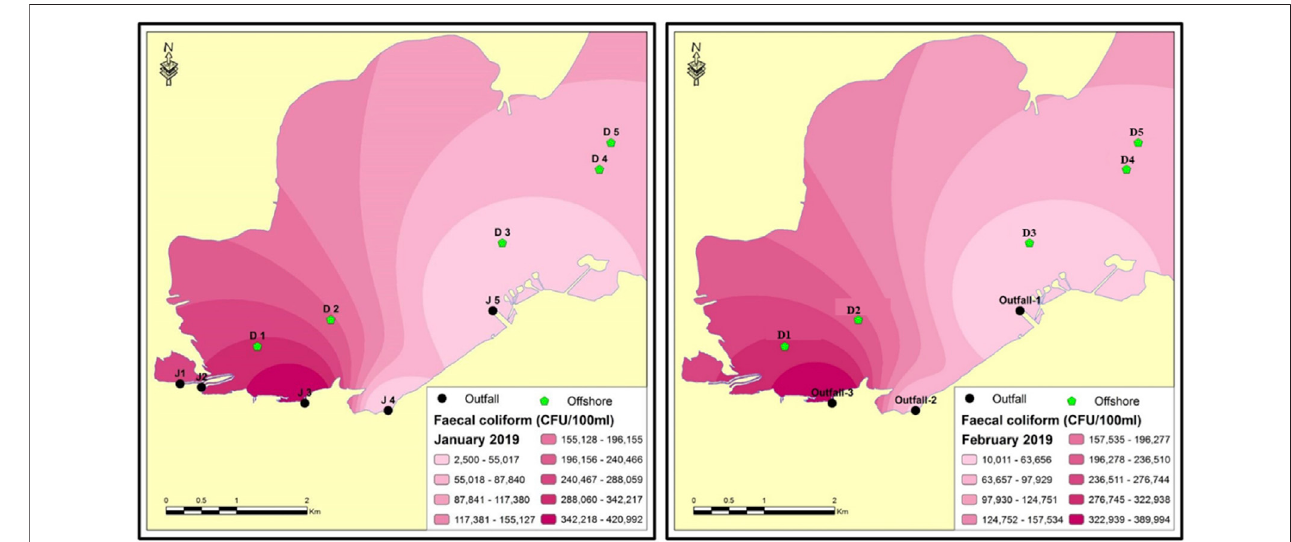
FIGURE 6 | Distribution of fecal coliform in Doha Bay using ArcGis.